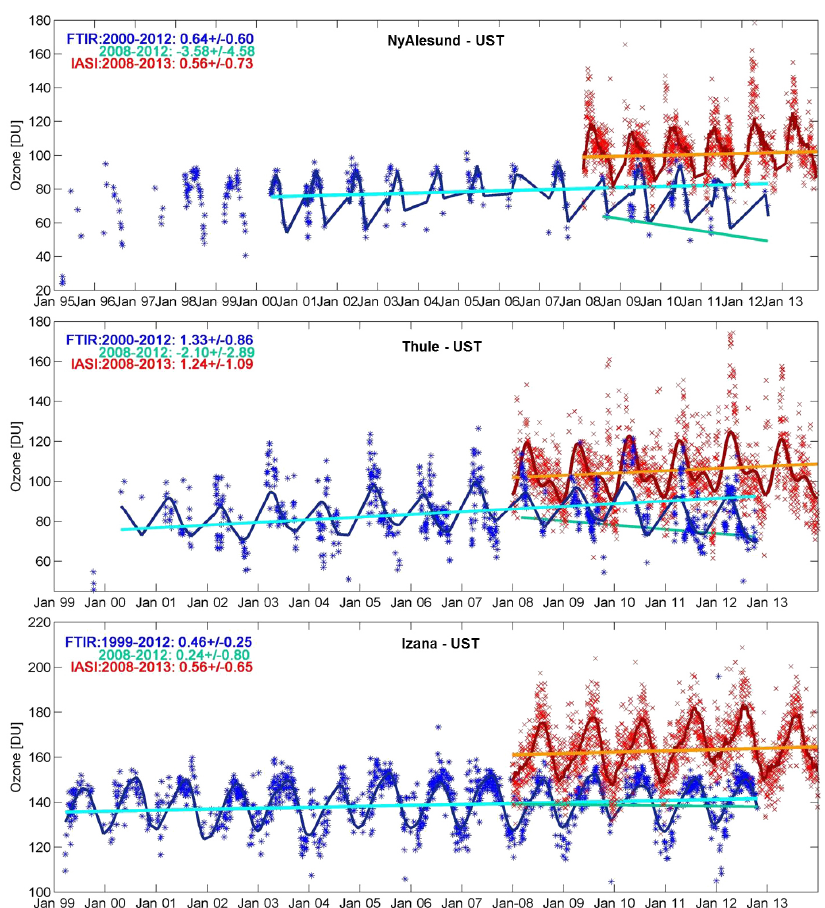
Figure 10. Daily time series of O 3 FTIR (blue symbols) and IASI (red symbols) measurements in the UST at Ny-Ålesund (top), Thule (mid- dle) and Izana (bottom), covering the 1995–2012 and the 1999–2012 periods, respectively (given in DU). The fitted regression models (dark blue and dark red lines, for FTIR and IASI, respectively) and the linear trends calculated for periods starting after the turnaround over 1999/2000–2012 and over 2008–2012 for FTIR (light blue and green lines), and the 2008–2013 period for IASI (orange line) are also represented (DUyear − 1 ). The trend values given in DUyear − 1 are